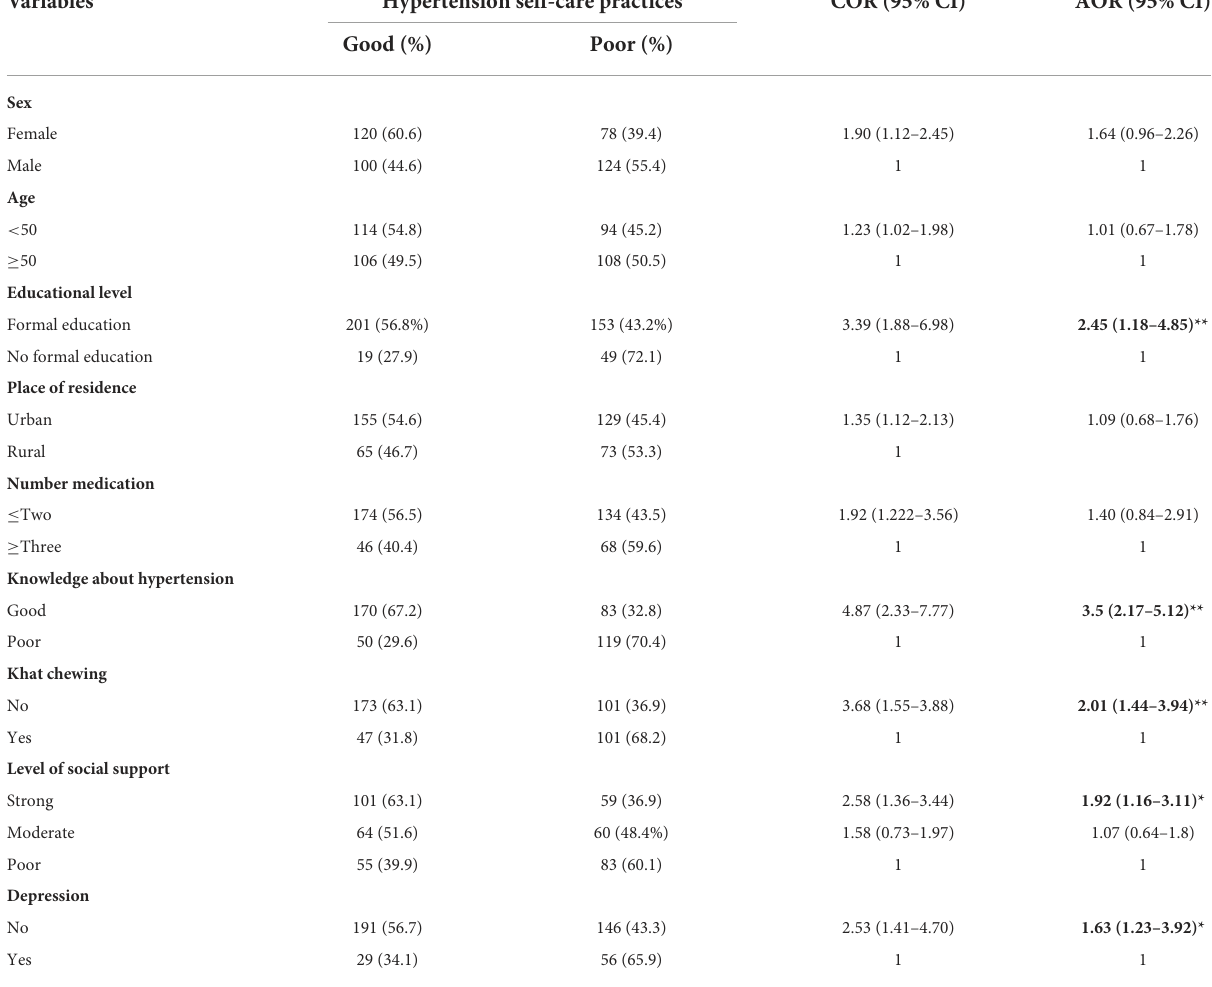
TABLE 3 Factors associated with self-care practices of hypertensive patients on follow-up at public Hospitals in the Harari regional state and Dire Dawa City administration, Eastern Ethiopia, 2022 ( n = 422).